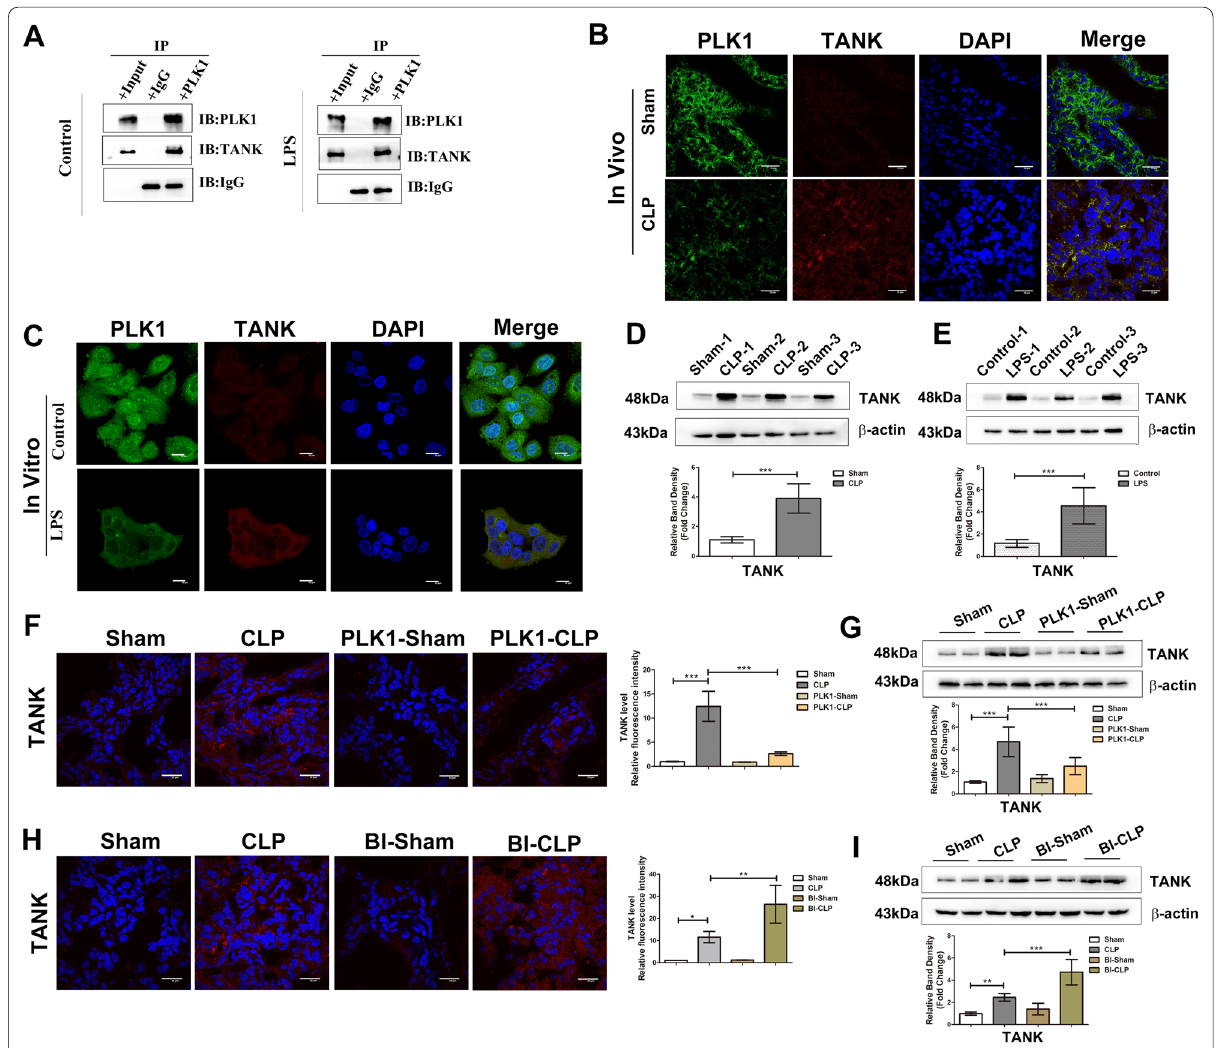
Fig. 5 PLK1 physically interacts with TANK and inhibits TANK expression in the intestinal epithelium. A PLK1 physically interacted with TANK in Caco‑2 cells with or without LPS treatment. B , C The location of PLK1 (green) and TANK (red) in the intestinal epithelium or Caco‑2 cells after the indicated treatments. The nuclei are stained blue. The scale bar represents 20 μm. D , E Representative Western blots showing TANK after the indicated treatments in upper area, and the lower graph shows the relative band densities. F , H Representative microphotographs of TANK expression in the intestine after the indicated treatments (scale bar 20 μm). The graph shows the relative fluorescence intensity. G , = I Representative Western blots showing TANK after the indicated treatments in the upper area, and the lower graphs show the relative band densities. The data in the graphs are expressed as the mean SD. * P < 0.05, ** P < 0.01, *** P < 0.001. (n ± =